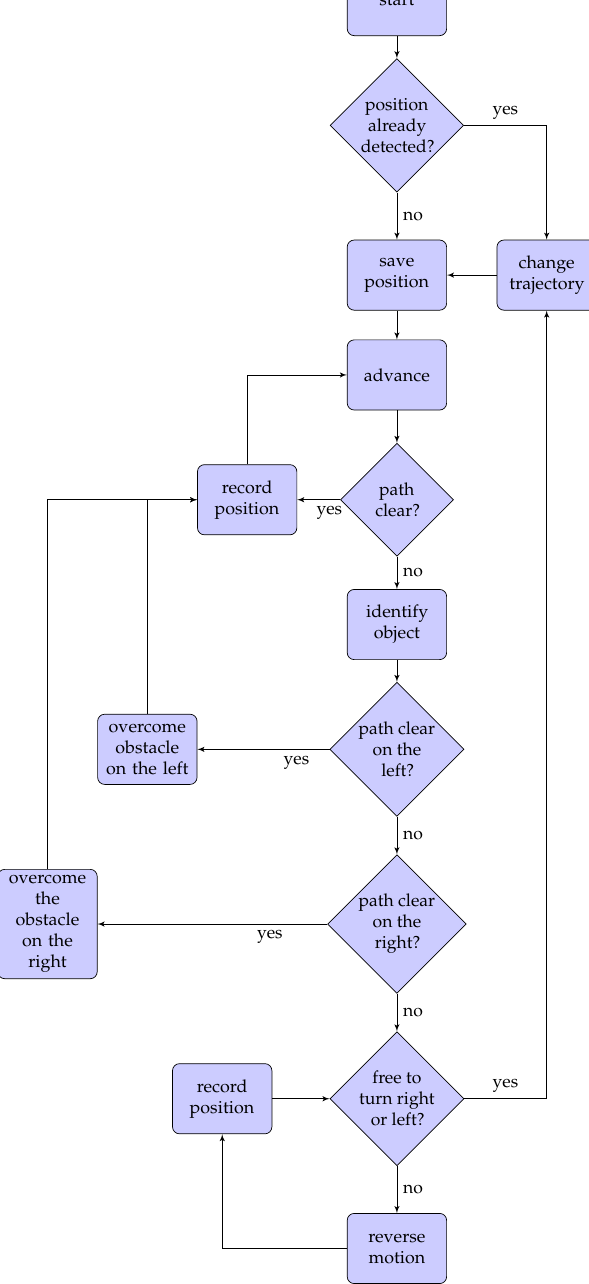
Figure 9. Program flowchart showing the overview of the robot navigation